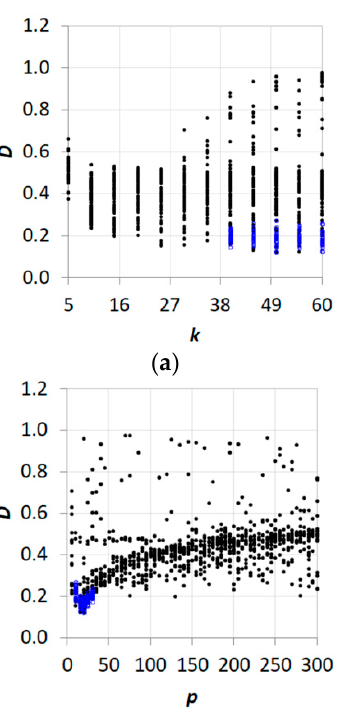
Figure 6. Segmentation parameters optimized on reference areas in the temperate period: ( a ) D versus k ; ( b ) D versus p ; ( c ) D versus s ; ( d ) D versus d , dispersions.